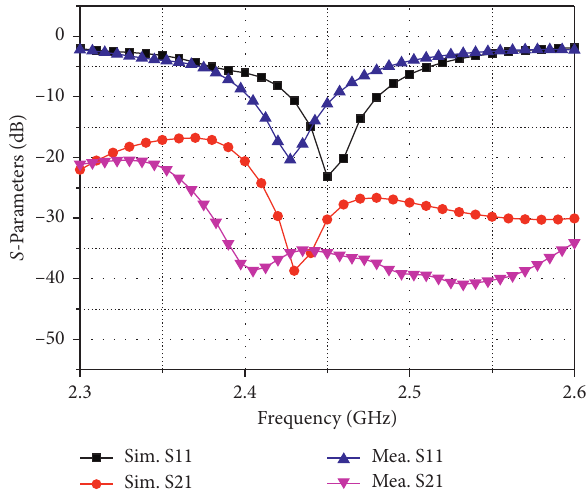
Figure 12: Simulated and measured S -parameters of the fabricated